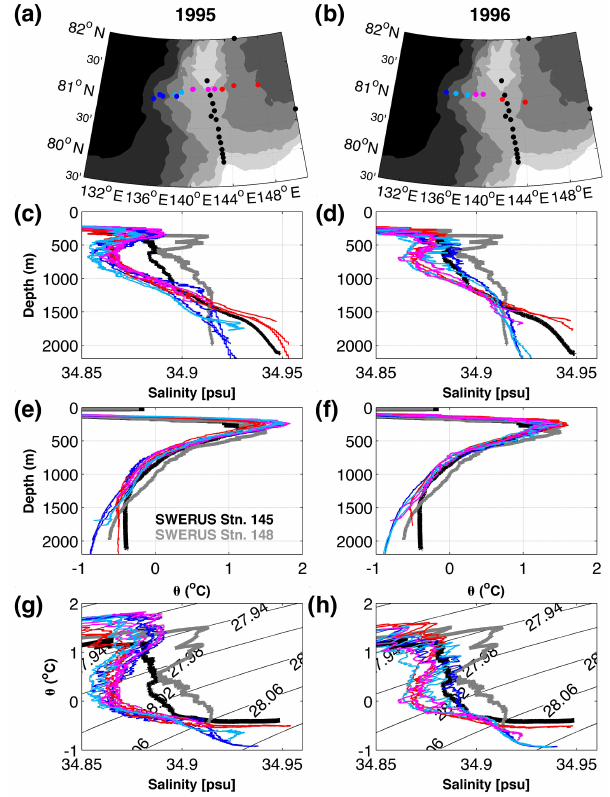
Figure 6. Historical water mass distributions across the Lomonosov Ridge. Potential temperature θ and salinity profiles and potential temperature–salinity plots for two sections taken at 81 ◦ N in 1995 (a, c, e, g) and 1996 (b, d, f, h) . The black and gray profiles mark the SWERUS-C3 reference stations for the Makarov (stn. 145) and Amundsen basins (stn. 148), respectively. The historical stations are color-coded according to longitude and water mass characteristics and are marked in the same color in the maps in panels (a) and (b) . Black dots show the SWERUS-C3